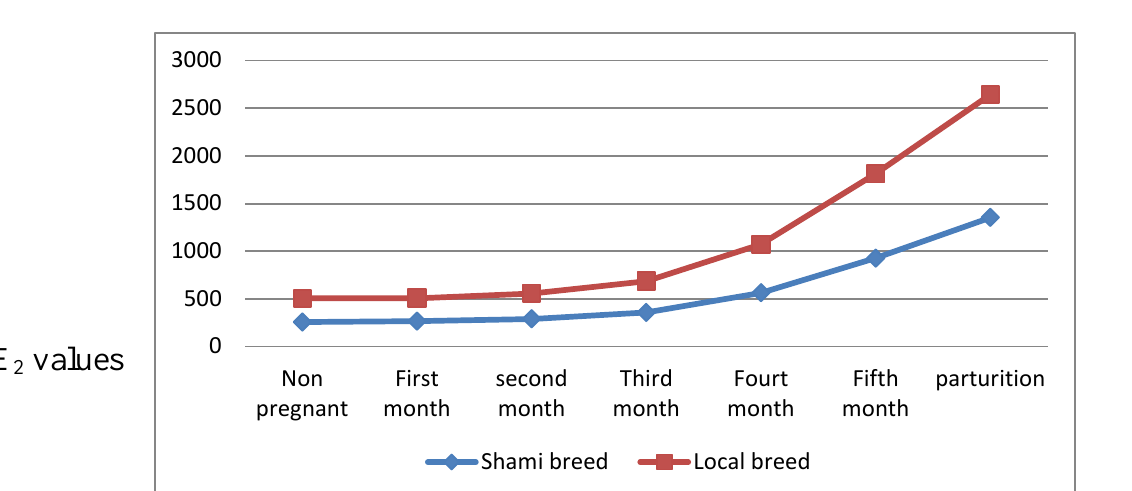
Different small letters represented significant different at the level of (P<0.05) with in